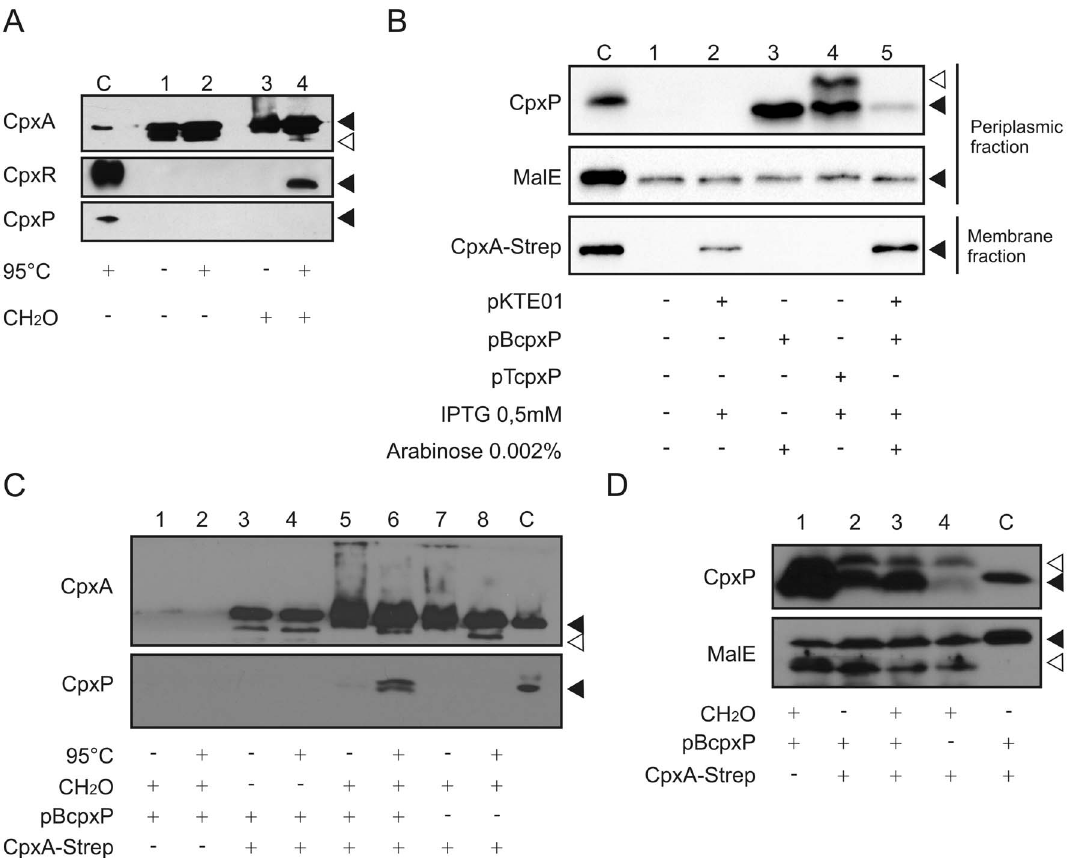
Figure 2. Membrane-SPINE demonstrates physical interaction between CpxP and CpxA in vivo. A) E. coli TG1 producing CpxA-Strep (pKT01E) was grown in LB to OD600=1.3 and crosslinking was performed for 20 min with 0.6% formaldehyde (CH 2 O). TG1 carrying the CpxA-Strep producing plasmid pKT01E without formaldehyde treatment served as a control. Cytosolic membranes were prepared, membrane proteins were solubilized by detergent treatment and CpxA-Strep was purified according to our established protocol for mSPINE [31,32]. Aliquots of each sample were incubated at 95 u C for 20 min to separate cross-linked proteins from CpxA-Strep and subjected to immunological detection using antiserum to the CpxA, the CpxR and the CpxP protein, respectively. Purified CpxA-His6, His6-CpxR and His6-CpxP served as controls for antibody specificity (C). Black triangles show specific and the white triangle unspecific reactions. Shown are representatives of two biological replicates. B) To check the protein level of CpxP, cell fractionation assays were performed. E. coli TG1 cells producing CpxA-Strep (pKT01E) and CpxP from different vectors (pTcpxP, pBcpxP) were grown in LB to OD600=0.6. Periplasmic fractions and membrane fractions were prepared and subjected to immunological detection using antiserum to the CpxP protein, the Strep-tag and the MalE protein (loading control), respectively. Purified His6-CpxP, CpxA-Strep and MalE served as controls for antibody specificity (C). C) mSPINE experiments were performed as described in (A) with E. coli TG1 producing CpxA-Strep (pKT01E) and CpxP (pBcpxP) grown in LB supplemented with 0.5 mM IPTG and 0.002% arabinose. Cells expressing cpxA without a Strep-tag (pEC01E) and cpxP (pBcpxP) with formaldehyde treatment (lanes 1 and 2) and cells carrying the CpxA-Strep producing plasmid pKT01E without formaldehyde treatment (lanes 3 and 4) served as controls. Purified CpxA-His6 and His6-CpxP served as controls for antibody specificity (C). Black triangles show specific and the white triangle unspecific reactions. Shown are representatives of two biological replicates. D) To verify similar CpxP protein level in each mSPINE experiment, whole cells from (C) were collected after formaldehyde treatment, and subjected to immunological determination using antiserum to the CpxP protein, and the MalE protein (loading control), respectively. Purified His6-CpxP and MalE served as controls for antibody specificity (C). Black triangles show specific and white triangles unspecific